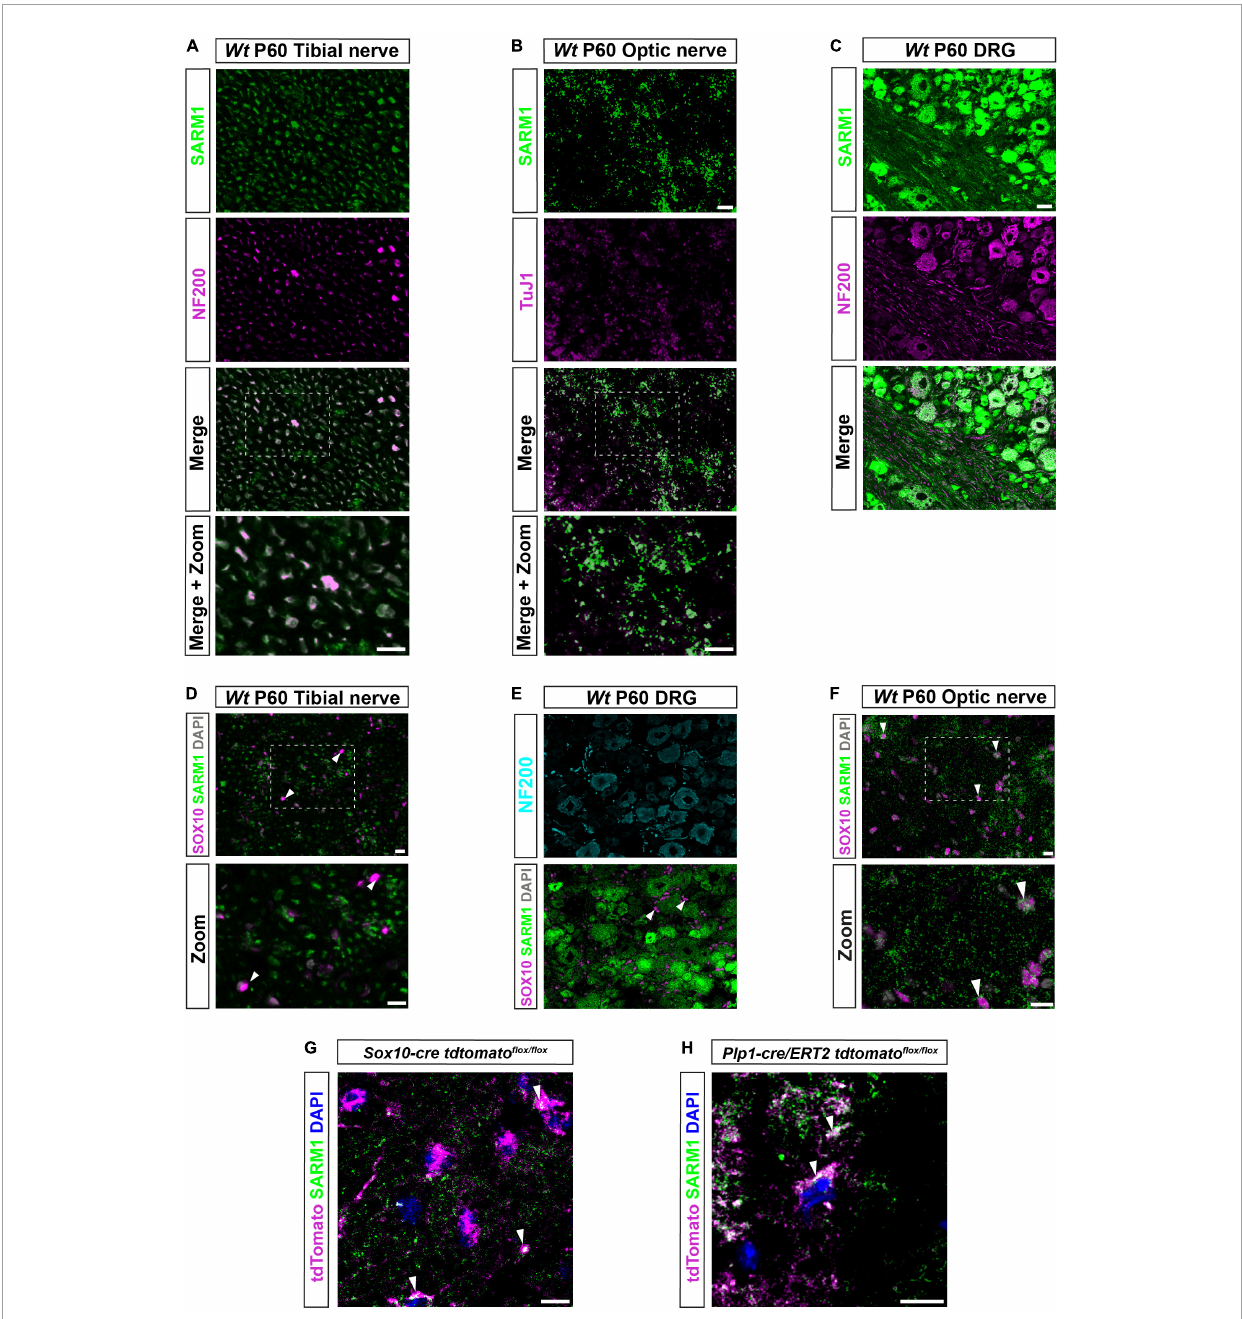
FIGURE1 SARM1 protein is detectable in CNS myelinating glia but not PNS glia. (A) Representative immunofluorescence images of transverse sections of Wt mouse tibial nerves to show co-localization of SARM1 (green) and NF-200 (neurofilament light chain; magenta) in axons. Zoomed area is represented by the white bounding box. Scale bars 10 µ m. (B) Representative immunofluorescence images of transverse sections of Wt mouse optic nerves to show expression of SARM1 (green) in TUJ1 (Anti-Beta III Tubulin; magenta) positive axons. Zoomed area is represented by the white bounding box. Scale bars 10 µ m. (C) Representative immunofluorescence images of transverse sections of Wt mouse DRGs to show co-localization of SARM1 (green) and NF-200 (magenta) positive neurons. Scale bar 25 µ m. (D) Representative immunofluorescence images of transverse sections of Wt and Sarm1 KO mouse tibial nerves showing SARM1 (green) and SOX10 (magenta) expression. White arrowheads show co-localization of DAPI (gray) and SOX10 (magenta), but no expression of SARM1 (green). Zoomed areas are represented by the white bounding box. Scale bar 10 µ m. (E) Representative immunofluorescence images of transverse sections of Wt and Sarm1 KO mouse DRGs showing NF200 (cyan), SARM1 (green) and SOX10 (magenta) expression. White arrowheads point to SOX10 (magenta) positive satellite glia and DAPI (gray), with no colocalization of SARM1 (green). Scale bar 10 µ m. (F) Representative immunofluorescence images of transverse sections of Wt and Sarm1 KO mouse optic nerves showing SARM1 (green) and SOX10 (magenta) expression. White arrowheads point to SOX10 (magenta) positive oligodendrocytes and DAPI (gray), with perinuclear SARM1 staining (green). Scale bar 10 µ m. Zoomed areas are represented by the white bounding box. Scale bar 10 µ m. All experiments n = 3 (3 animals, 2 nerves per animal, 5 sections per nerve). (G) Maximum projection of tdTomato positive oligodendrocytes in P60 optic nerves of Sox10-cre Rosa26 stopflox tdtomato ( Sox10-cre tdtomato flox / flox ) positive for SARM1 immunolabelling (white arrowhead). Scale bar 10 µ m. (H) Single confocal z plane of tdTomato positive oligodendrocytes in P60 optic nerves of Plp1-cre/ERT2 Rosa26 stopflox tdtomato ( Plp1-cre/ERT2 tdtomato flox / flox ) positive for SARM1 immunolabelling (white arrowhead). Scale bar 10 µ